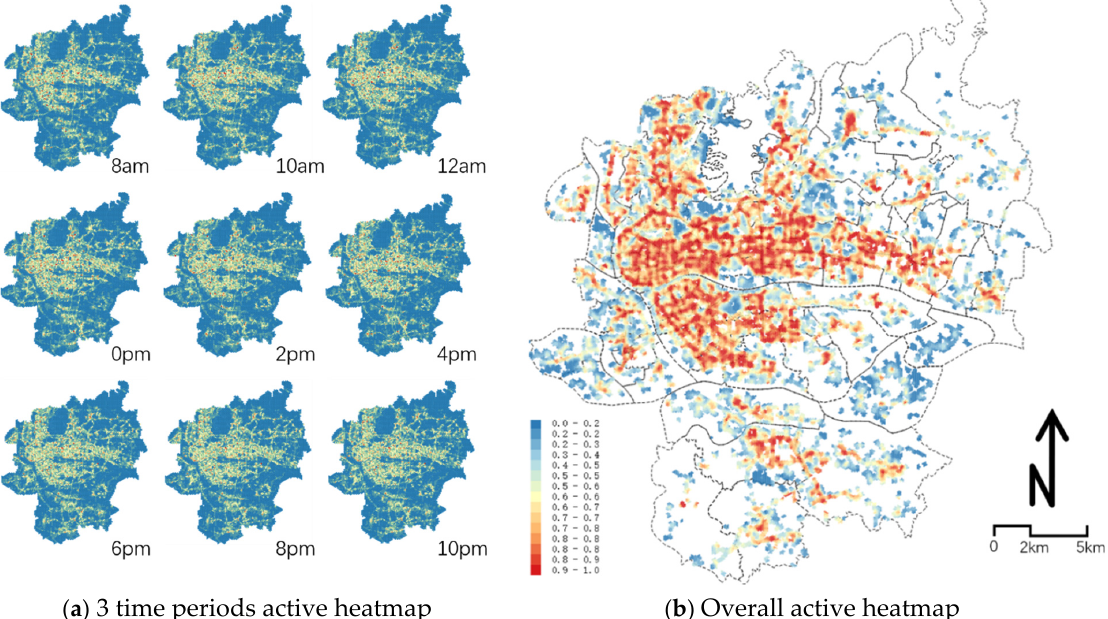
Figure 10. Demonstration of the spatial and time diversity distribution of street vitality.